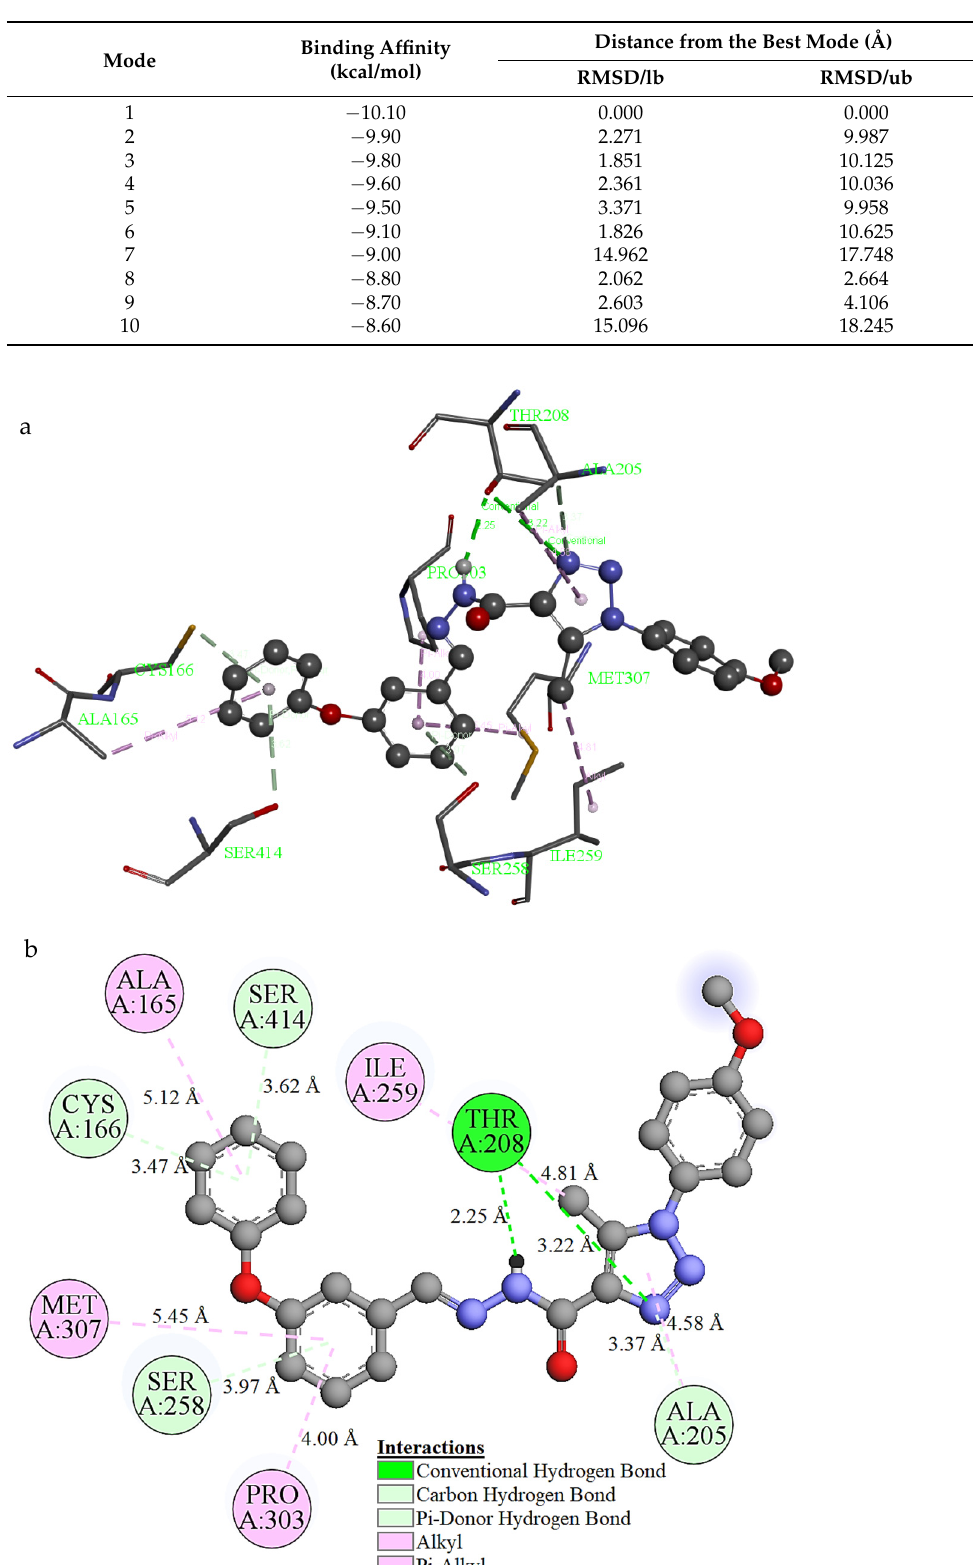
Table 9. The AutoDock Vina results for ten different poses of 2 docked into the A chain of the target macromolecule 2WYA.